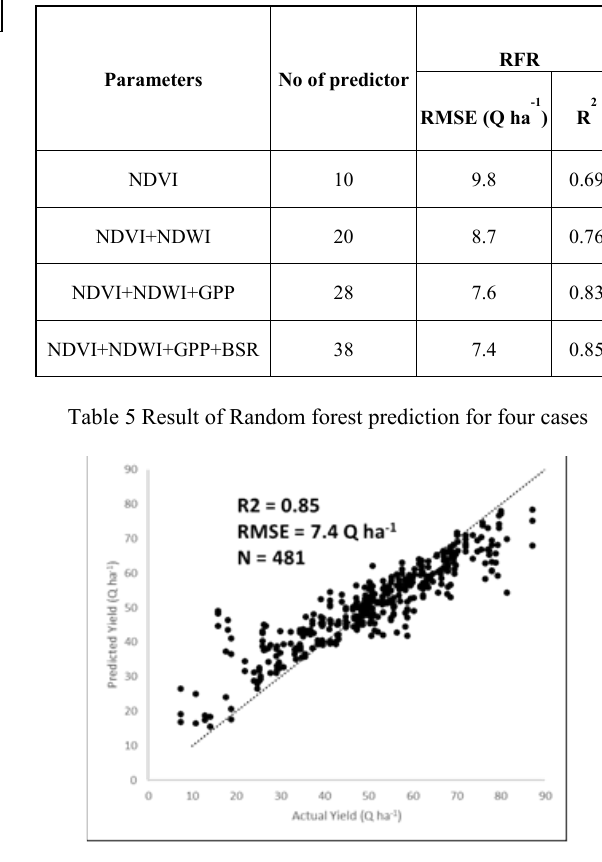
Fig. 5 Validation result for prediction using all four